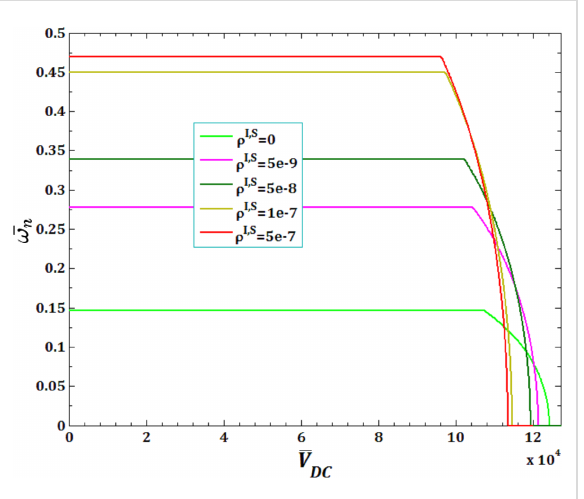
Figure 14: The effect of surface ρ S and interface ρ I mass density for pull-in voltage on DNF of SS FC-MWPENS.